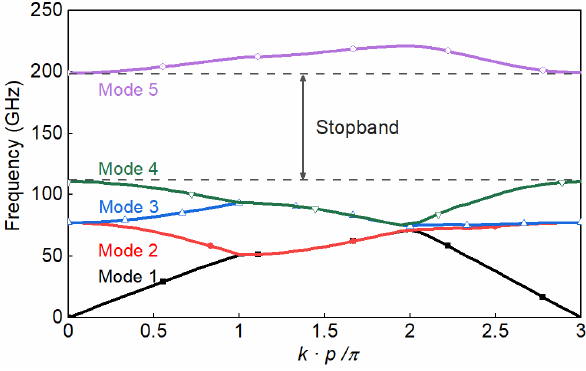
Figure 3. Dispersion diagram for the infinite periodic unit cell.